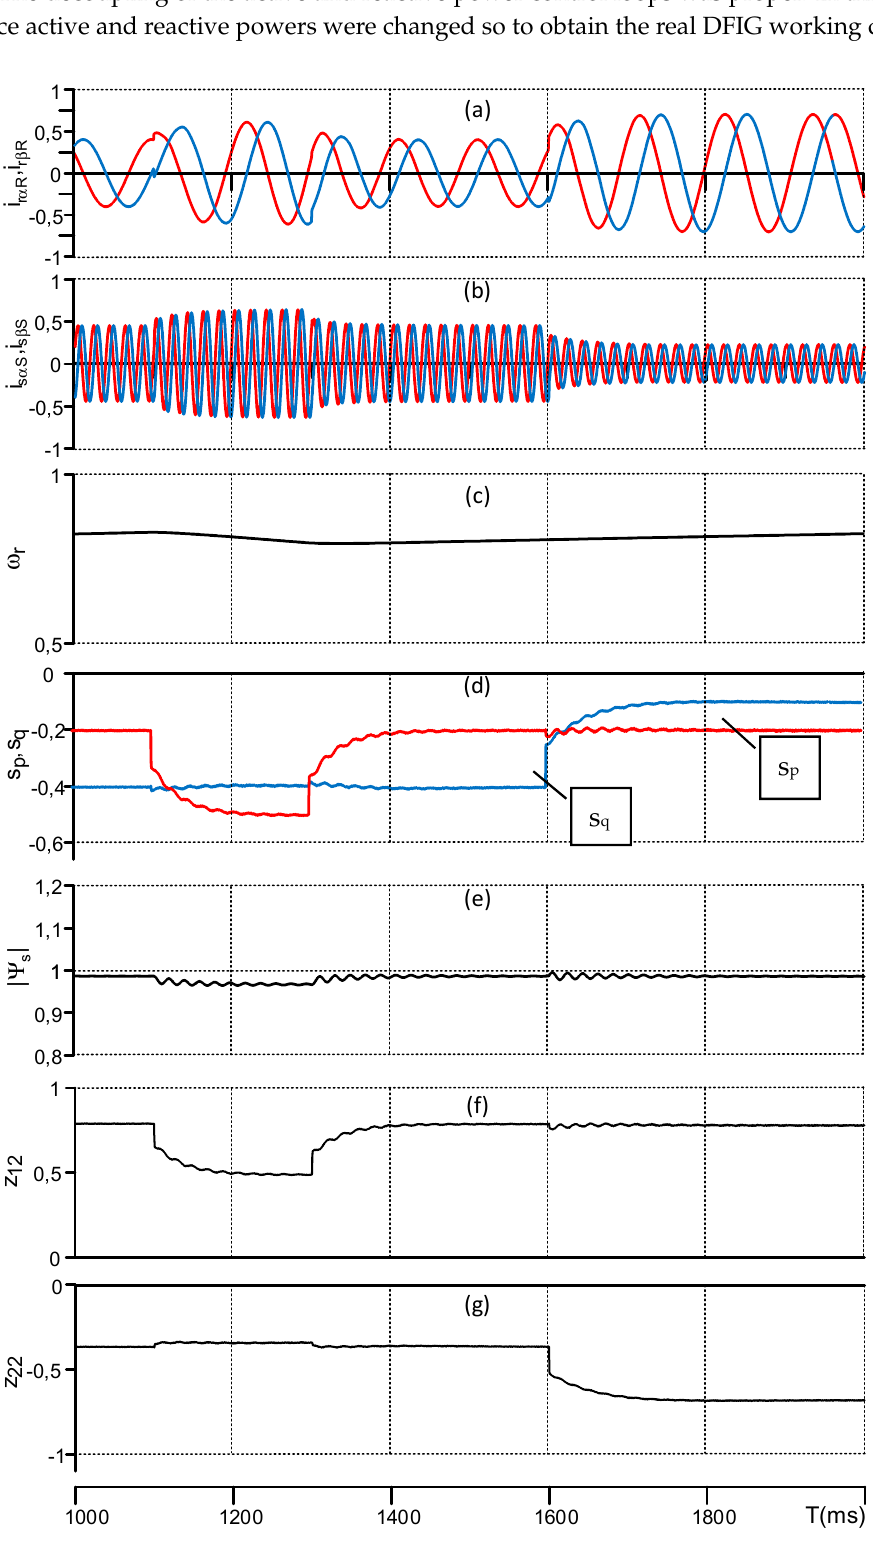
Figure 6. Simulation results of active s p (red) and reactive s q (black) power step responses in the nonlinear control system. ( a ) Rotor current vector components; ( b ) stator current vector components; ( c ) rotor speed; ( d ) active and reactive powers; ( e ) stator flux vector module ( f ) multi-scalar variable; ( g ) multi-scalar variable.